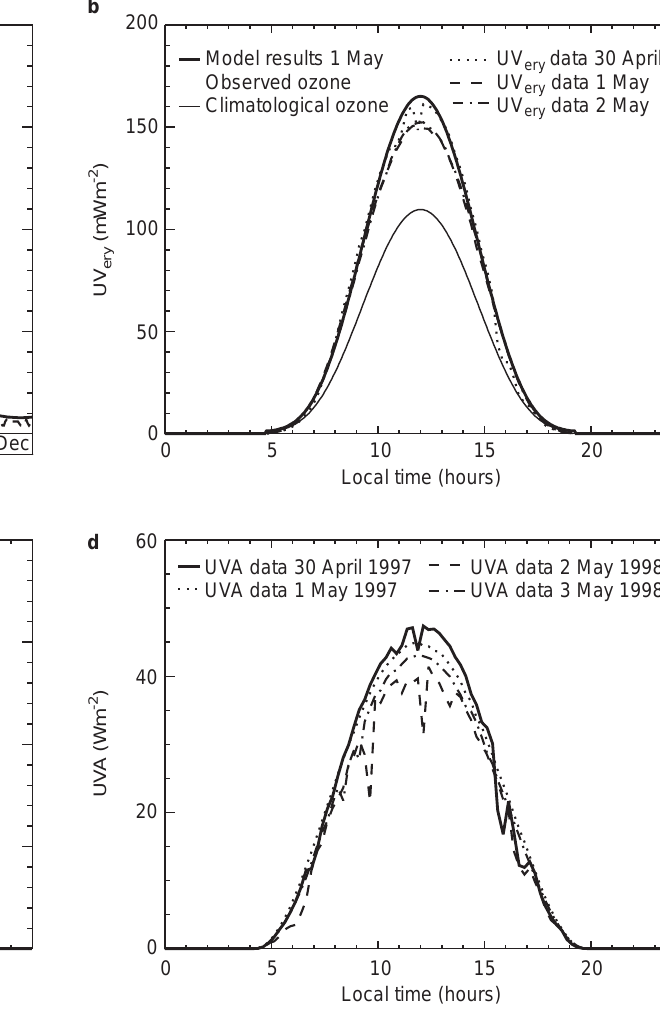
assuming climatological total ozone (373 DU). c UV ery data at Camborne on 2/5/1998 and 3/5/1998 ( broken lines ) together with calculated values for 3/5/1998 ( solid lines ). Upper solid curve : calculated values assuming the climatological total ozone (373 DU). Lower solid curve : calculated values assuming the total ozone value of 400 DU measured at Camborne. d UVA data at Camborne on 30/4/ 1997, 1/5/1997, 2/5/1998